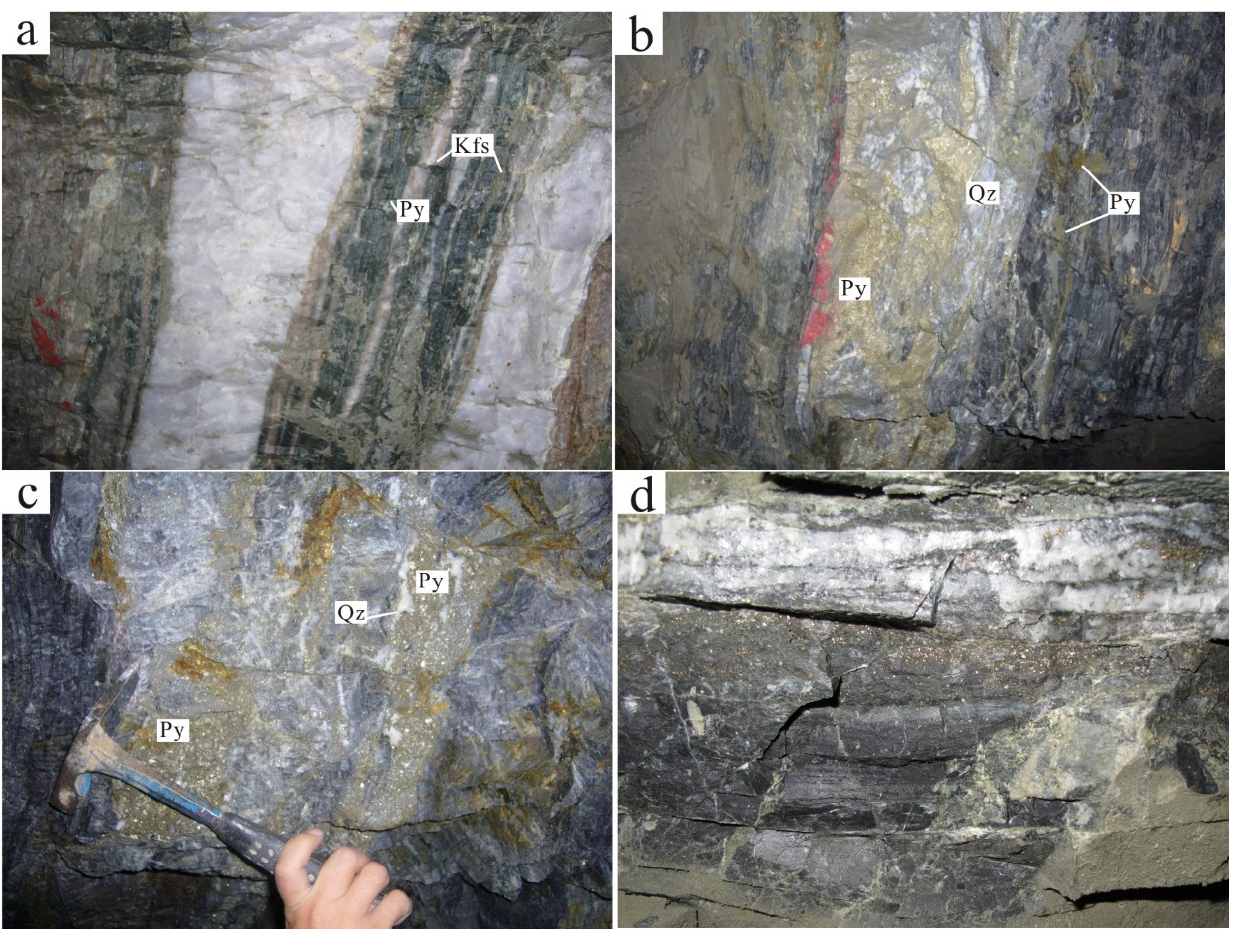
Figure 2. Ore and alteration styles of the Shenjiagou Au deposit. ( a ) Ore-bearing quartz–sulfide veins; ( b ) planar metal sulfidation in banded silicification; ( c ) planar metal sulfidation; and ( d ) disseminated metal sulfidation in banded silicification. Kfs, K-feldspar; Py, pyrite; Qz, quartz.